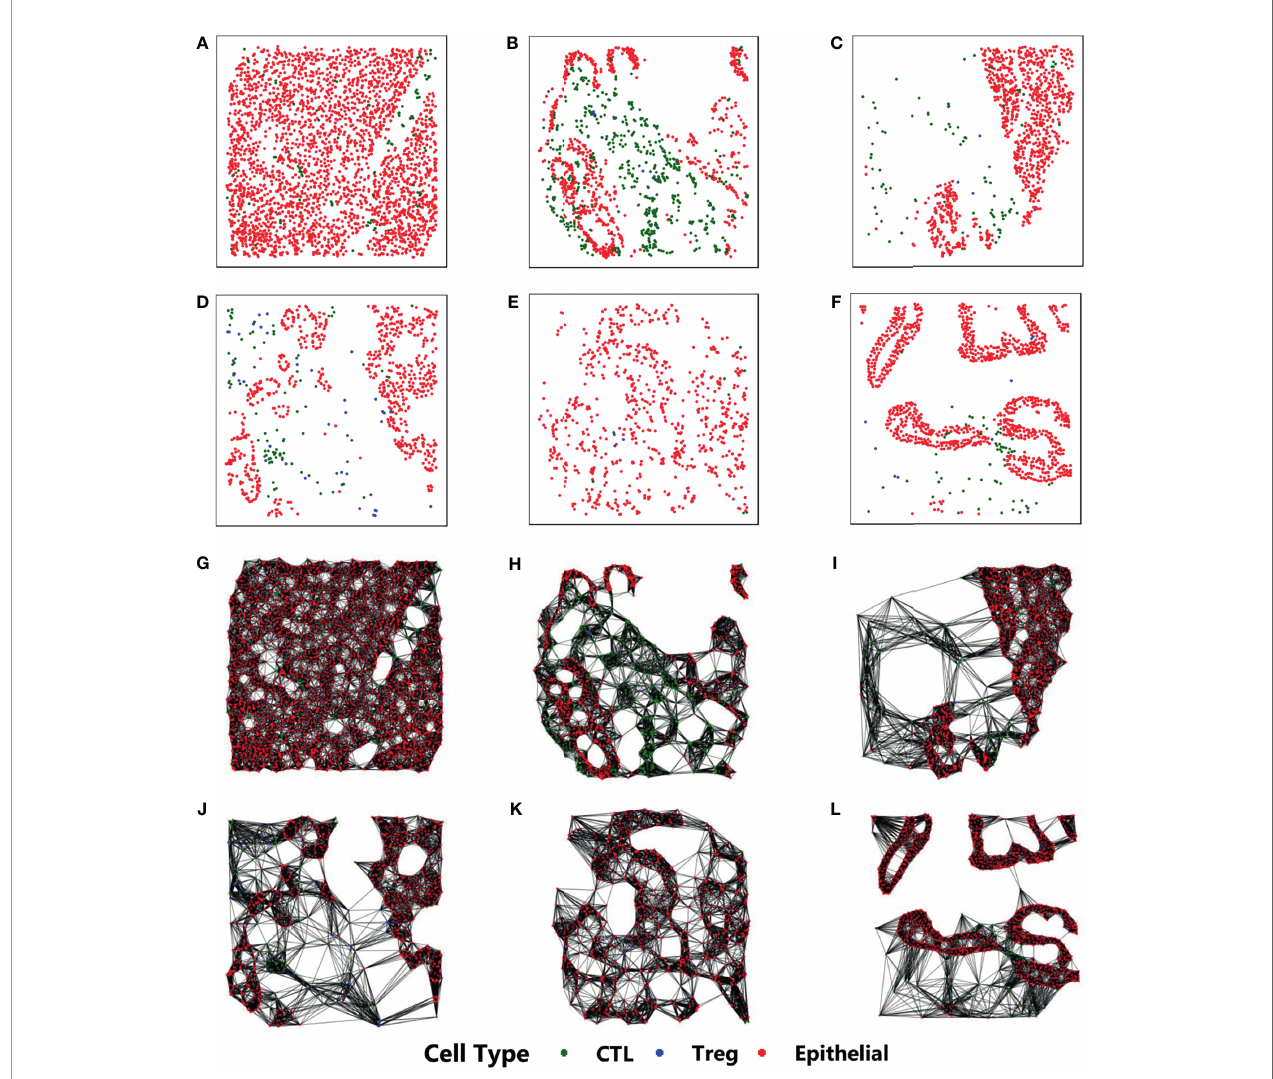
FIGURE 1 | Construction of k -NN graphs from point pattern data derived from mIF pathological images from six different classes: (A) CP, (B) IPMN, (C) MCN, (D) PanIN, (E) PDAC, (F) IPMN-associated PDAC. Their corresponding k -NN graphs are shown in (G – L) , respectively. In all images, the red, blue and green cells correspond to epithelial, cytotoxic lymphocytes, and t-regulatory cells,